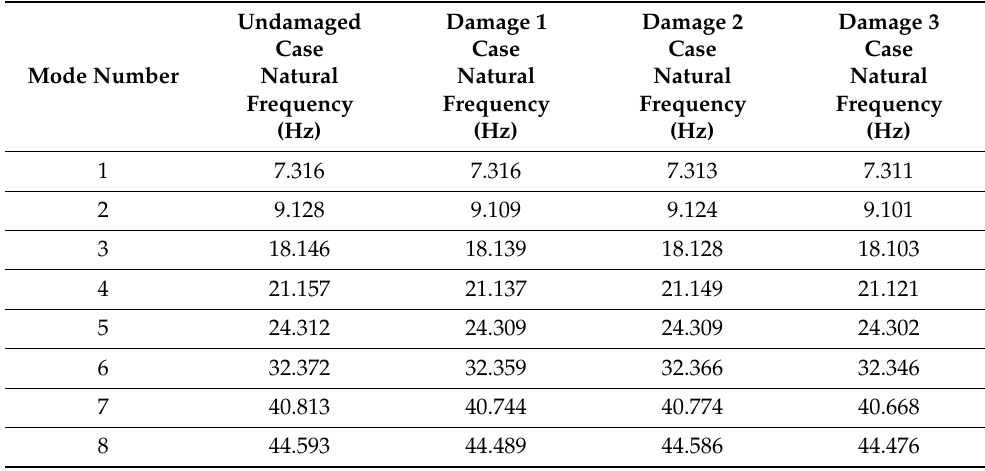
Table 1. Natural frequencies of first- to eighth-order modes of rigid-frame-bridge modeling according to damage